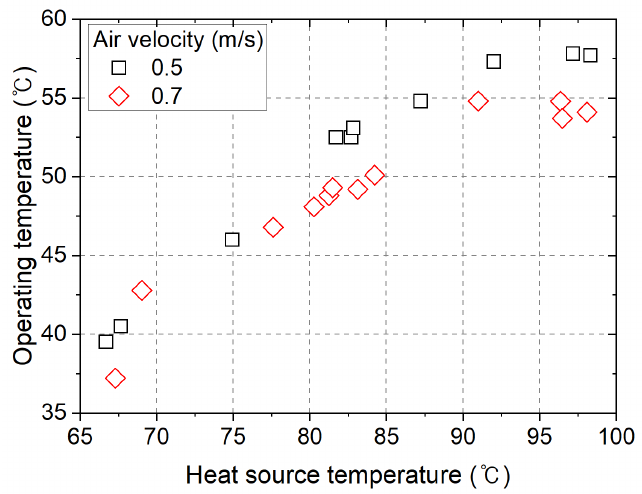
Figure 9. Average temperatures of the working fluid of the FHP model at various water-heating temperatures.